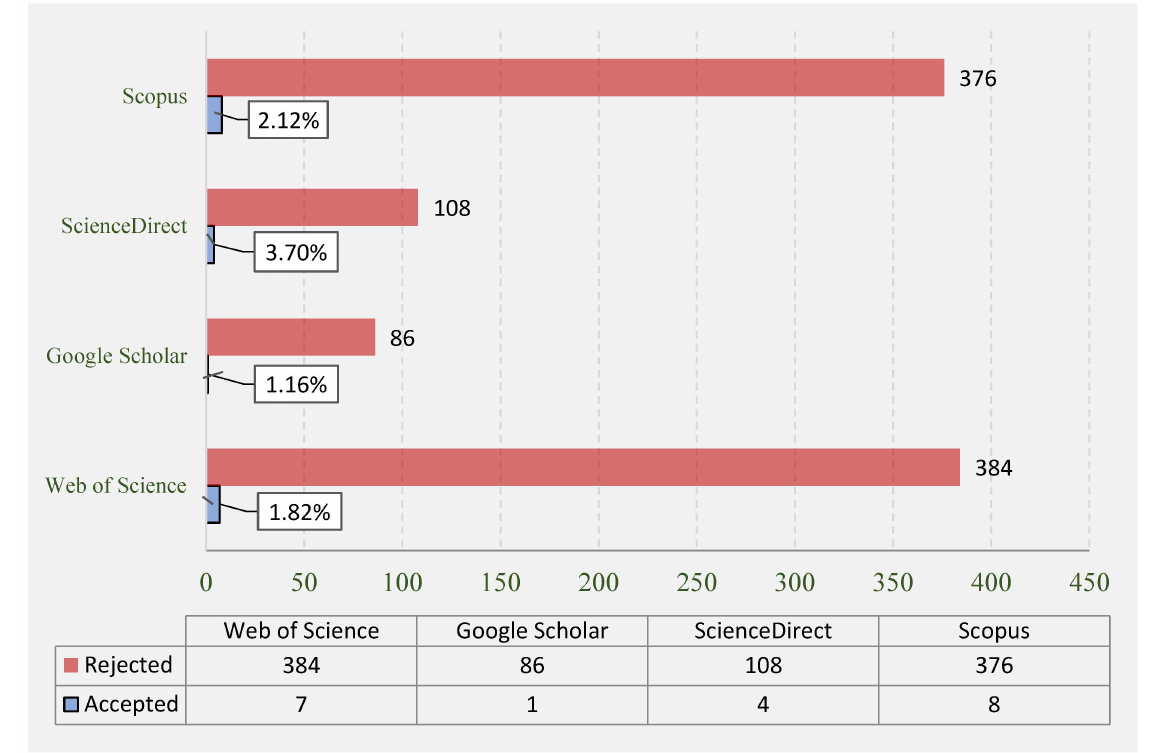
Figure 4. Number of accepted and rejected articles.